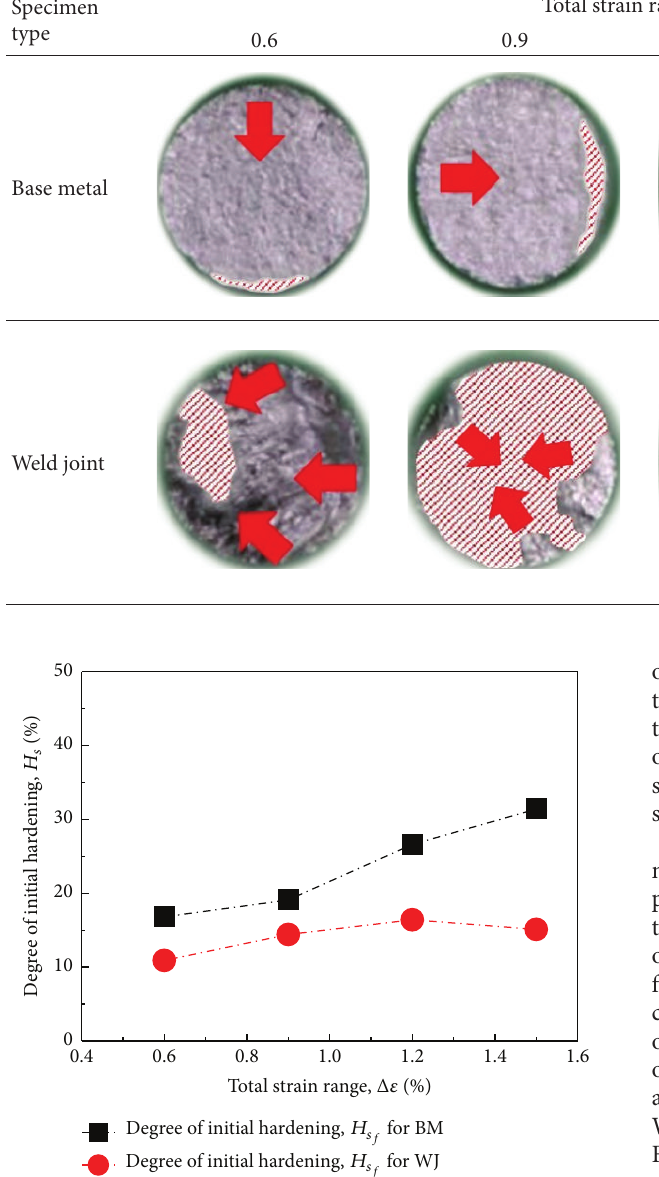
Figure 6: The degree of cyclic hardening factor on total strain range in Alloy 617 BM and Alloy 617